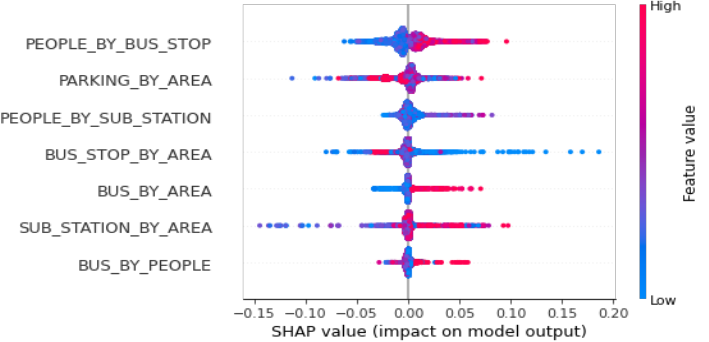
Figure 10. A summary plot for transportation-related features.